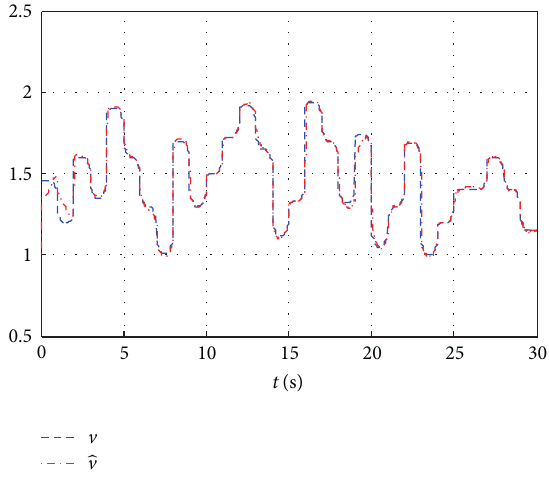
Figure 8: The unknown input and its